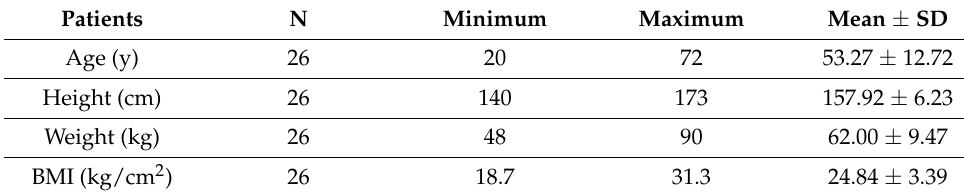
Table 1. Demographic data of patients (n = 26).